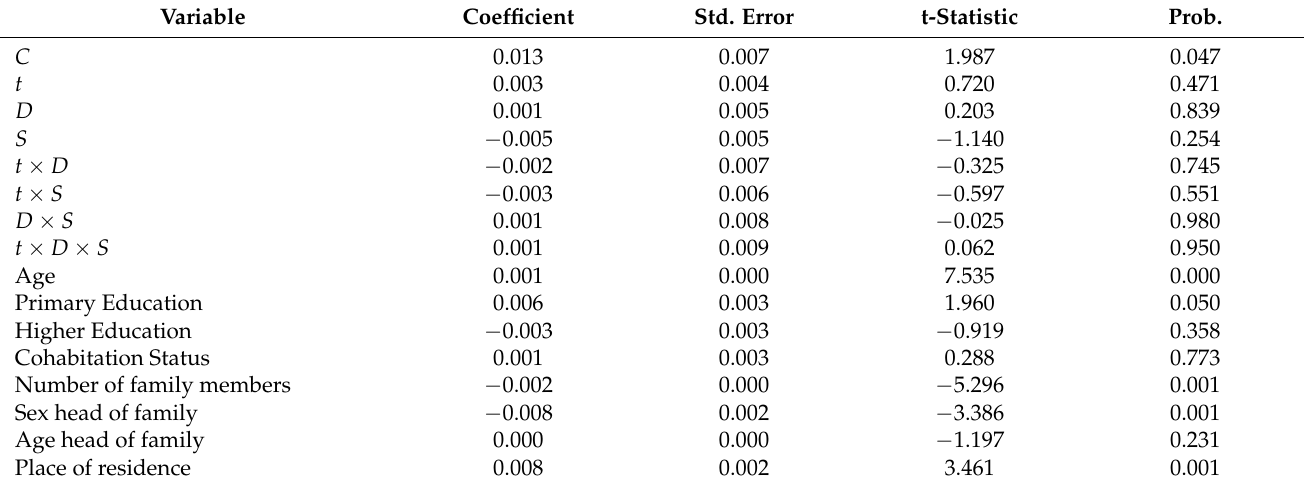
Table 5. The validation of parallel trends with the placebo test treatment